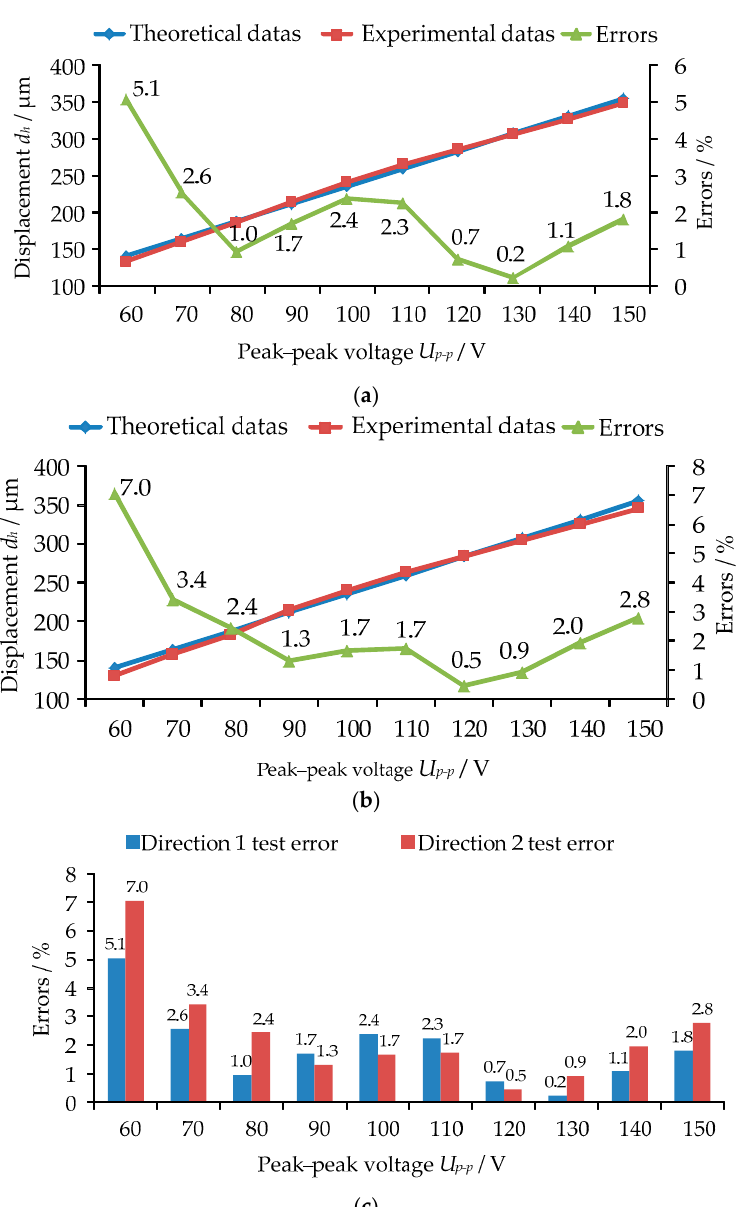
Figure 12. Experimental results of harmonic displacement for the proposed piezoelectric actuator. ( a ) Direction 1 test results; ( b ) Direction 2 test results; ( c ) The error between the experimental result and the theoretical calculation.